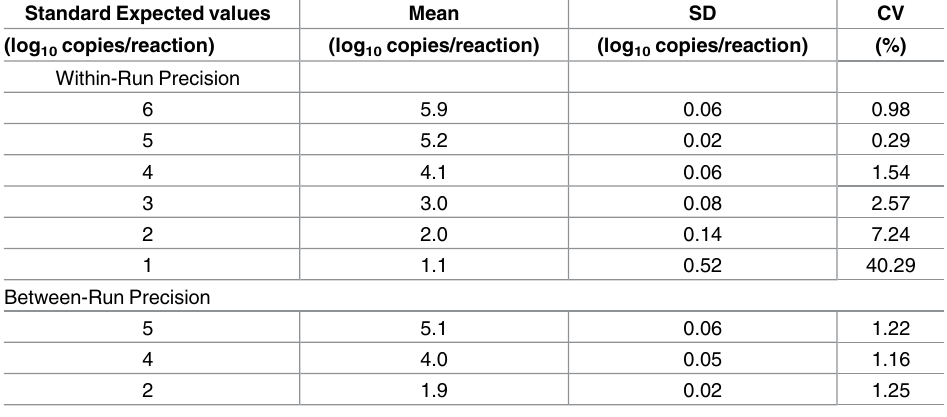
Table 1. Within-run and between-run precisions of the LightMix dengue virus EC qRT-PCR assay.